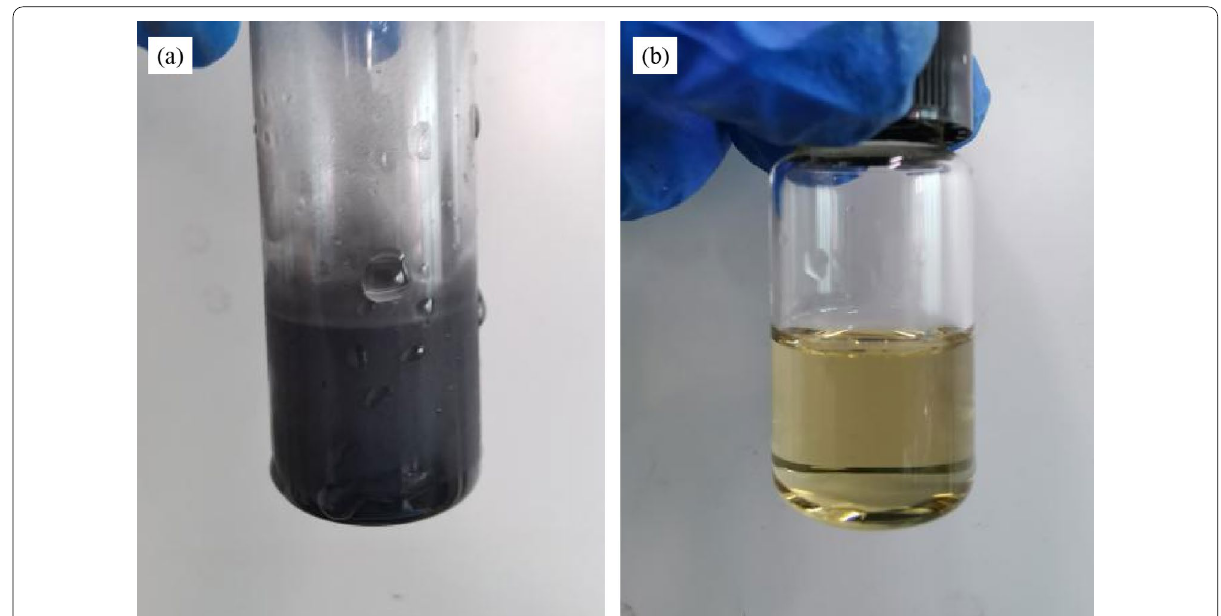
Fig. 1 MoS 2 nanosheet solution. a The ultrasonic MoS 2 solution before centrifugal cleaning, b the centrifuged MoS 2 nanosheet